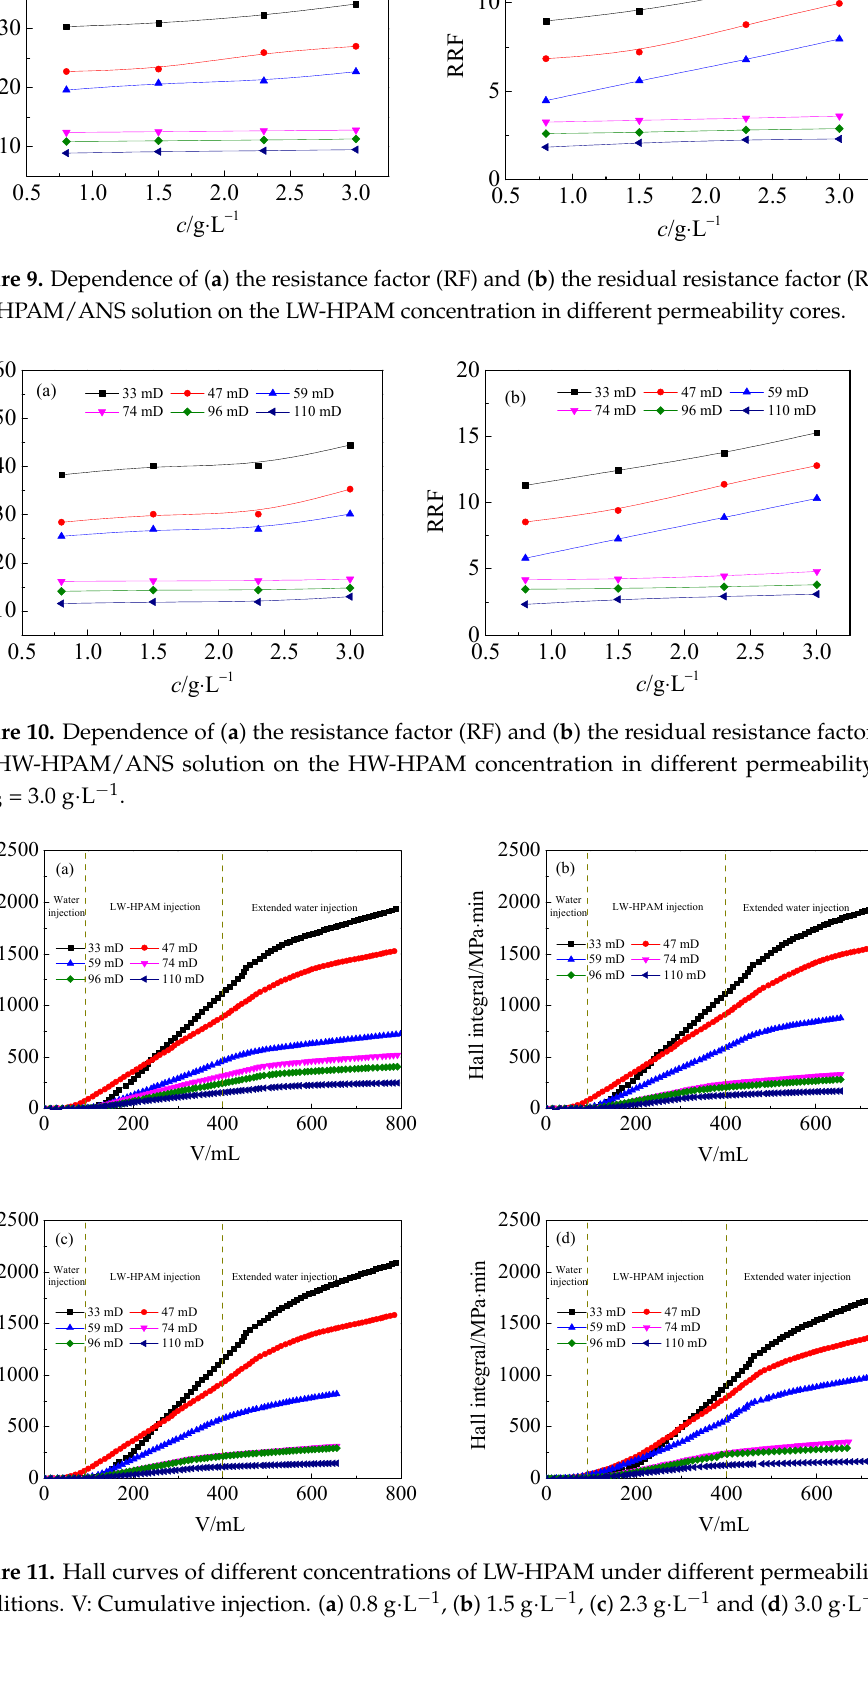
conditions. V: Cumulative injection. ( a ) 0.8 g · L − 1 , ( b ) 1.5 g · L − 1 , ( c ) 2.3 g · L − 1 and ( d ) 3.0 g · L − 1